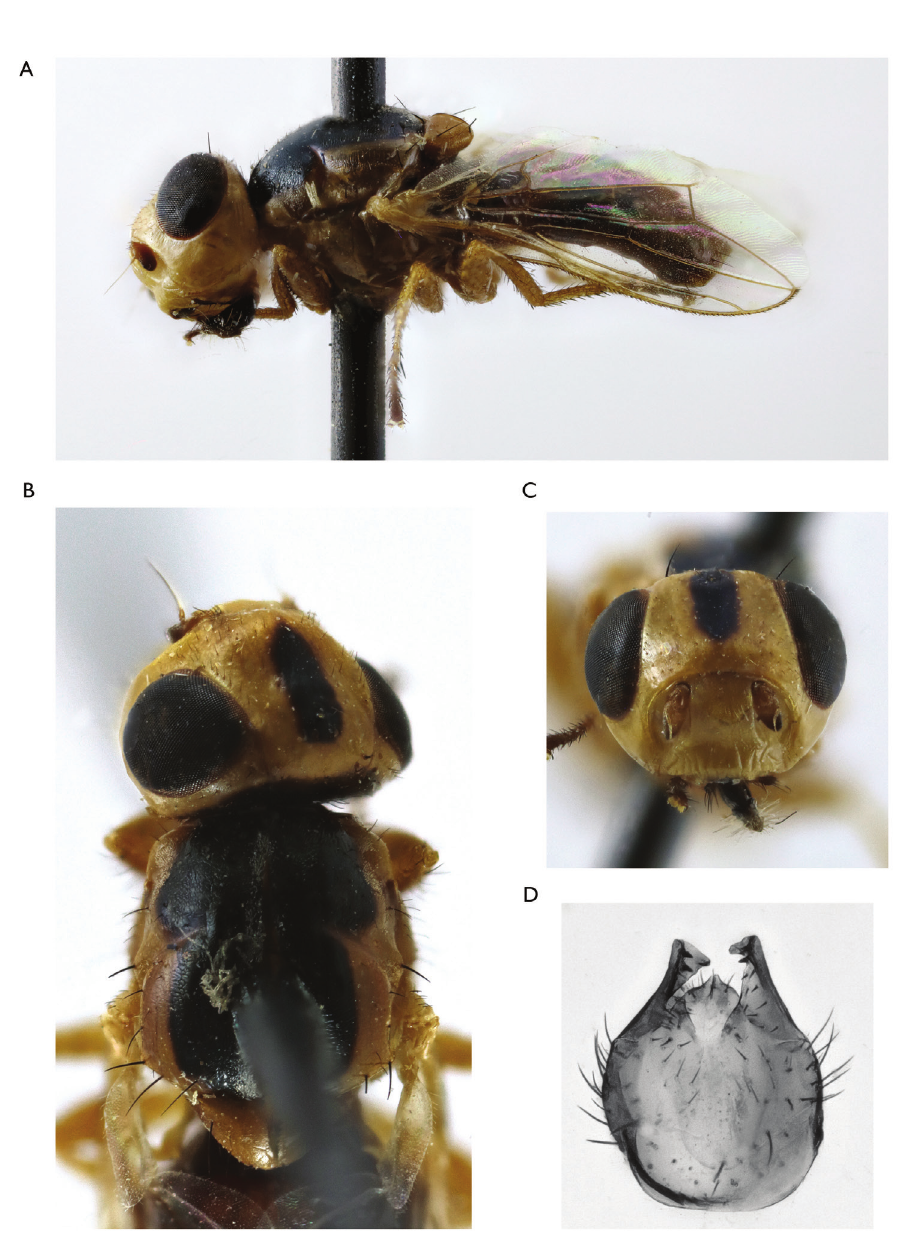
Figure 3. Timia mongolica Zaitzev, 1982, paratype male A habitus, lateral view B head and thorax, dorsal view C head, anterior view D epandrium, dorsal